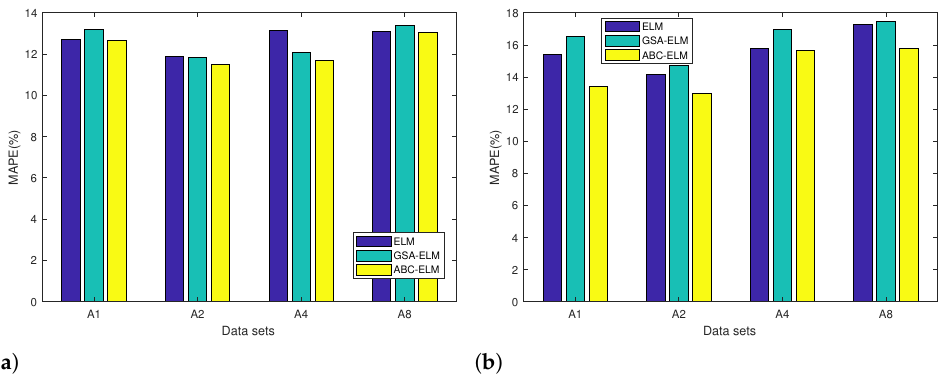
Figure 8. Comparison of MAPE ( a , b ) values of three learning models ELM, GSA-ELM, and ABC-ELM at 5 min and 20 min aggregation interval. ABC-ELM has the lowest MAPE values in all four datasets A1, A2, A4, A8. Table 6. The MAPE(%) of ABC-ELM at different aggregation intervals. Aggregation